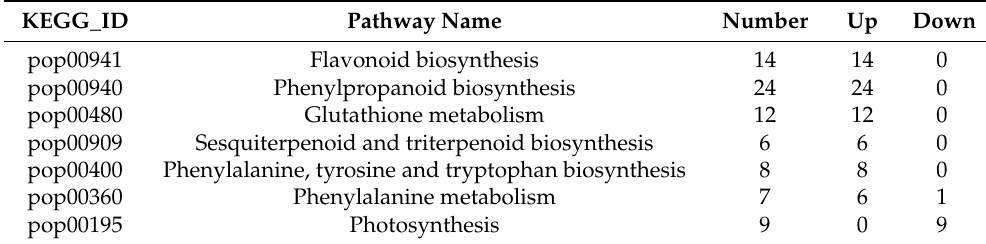
Figure 2. The annotation of DEGs in GO terms. The horizontal axis shows the two GO categories: the biological process, and molecular function; the vertical axis shows the number of DEGs annotated under each term. Table 2. Significantly enriched KEGG pathways of